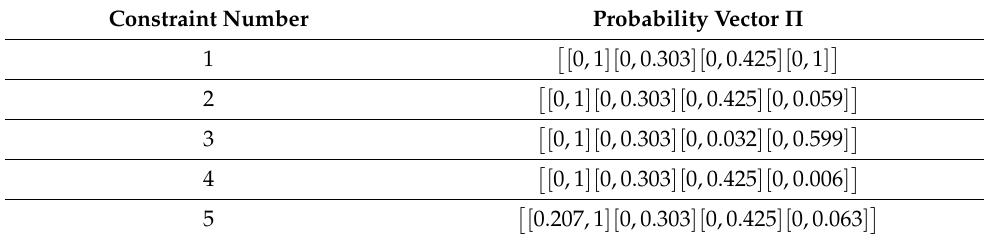
Table 3. The probability vector obtained after each constraint.